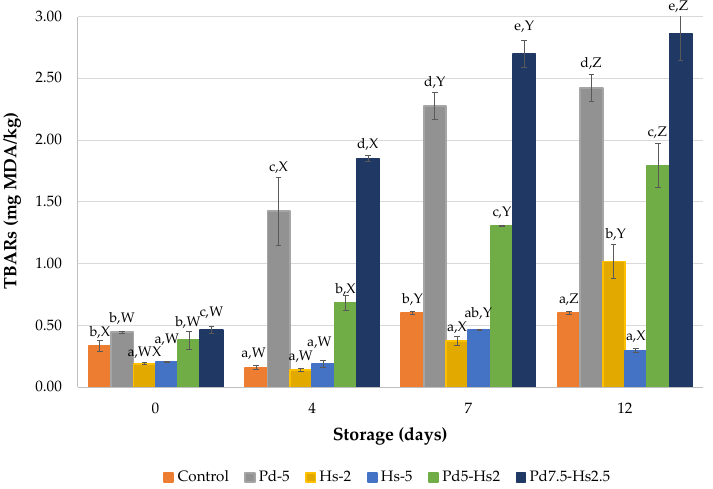
Figure 2. TBARs results (mg MDA/kg) of formulations with Pd and Hs powders. a–e Mean values for each day with different letters differ significantly ( p < 0.05). W–Z Mean values for each formulation with different letters differ significantly ( p < 0.05).